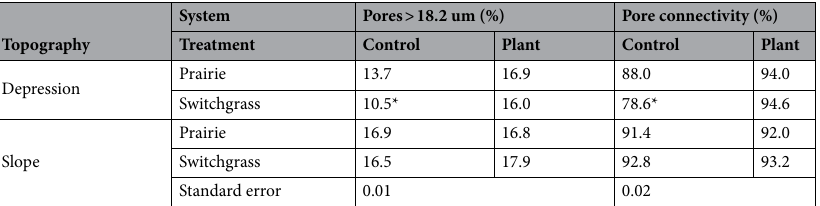
Table 3. Summary of soil pore characteristics for the studied prairie and monoculture switchgrass systems at the two topographical positions after plant growth experiment. Shown are means (n = 6) and standard errors for each system and topographical position in control and plant-grown cores treatment. Stars (*) indicate significant differences between plant-grown and control cores within each topography (p < 0.05) in each cropping system; upper case letters indicate significant differences between topographies in plant-grown cores (p < 0.05) in each cropping system and, lower case letters indicate significant differences between the cropping systems within each topographical position in plant-grown cores (p < 0.05). No * or letters are shown when the differences were not statistically